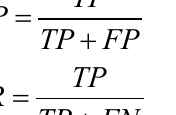
Table 2. Number of model parameters comparison